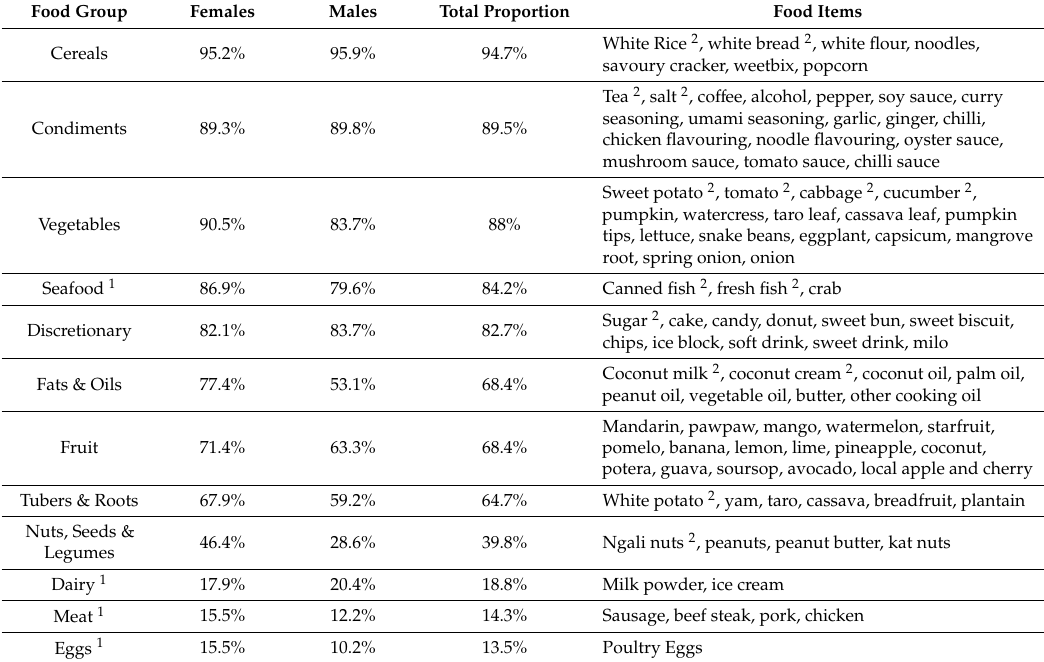
Table 2. Variety of all food items consumed from each food group and proportion of food group consumption by males and